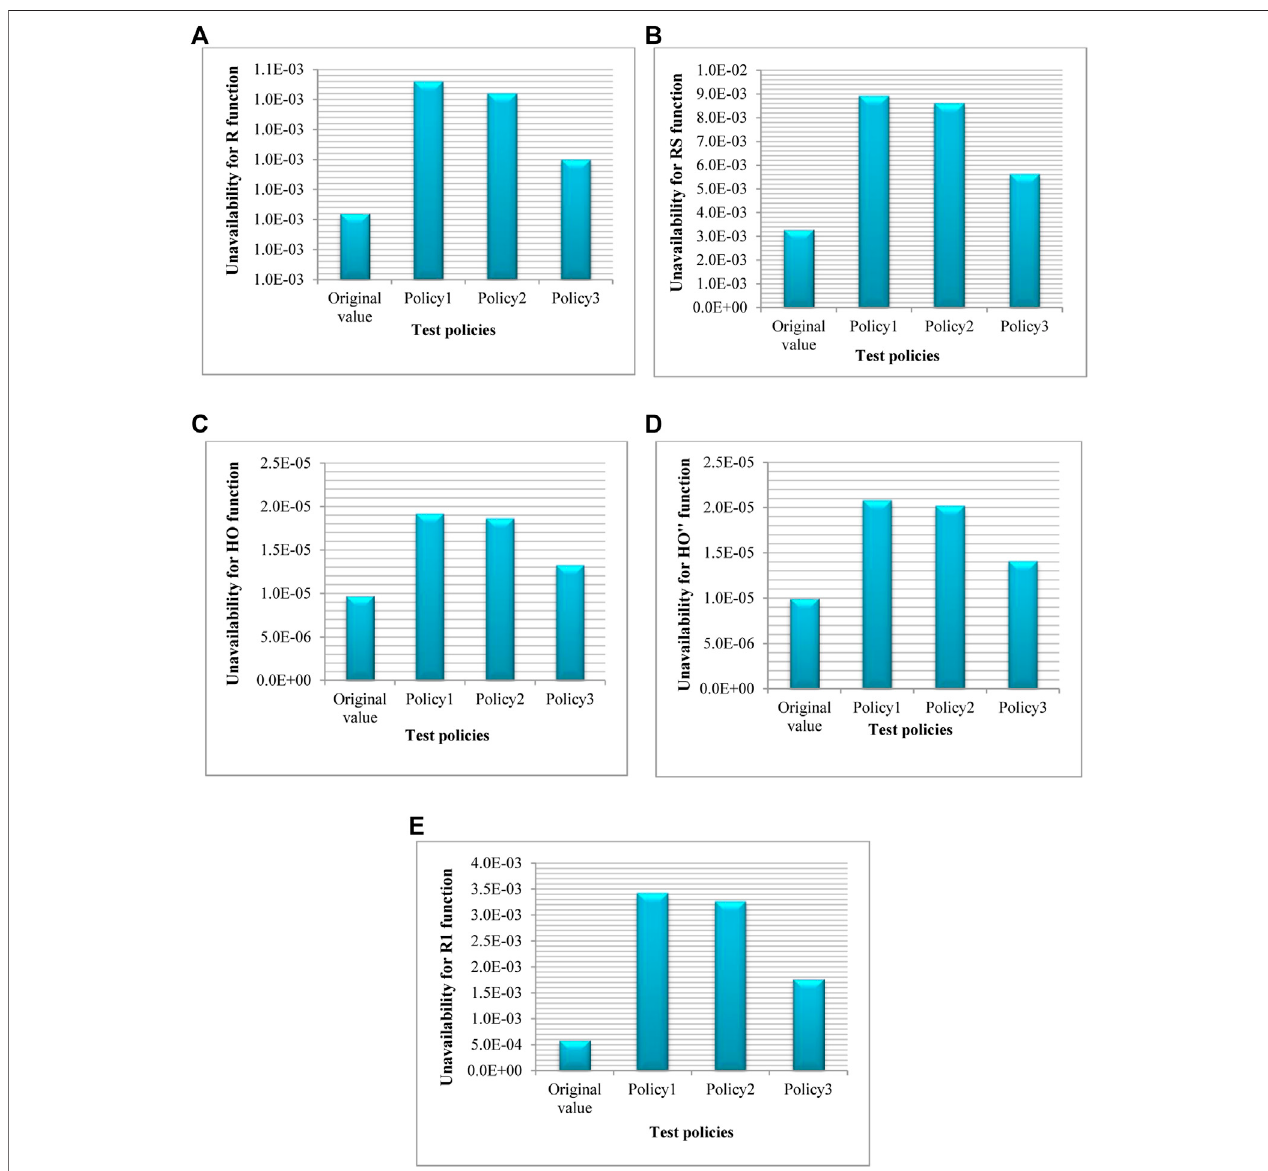
FIGURE 8 | Comparison of unavailability between different maintenance policies and originalvalue for functions of “ System for Emergency Cooling ” : (A) R, (B) RS, (C) HO, (D) HO ″ , and (E) R1.